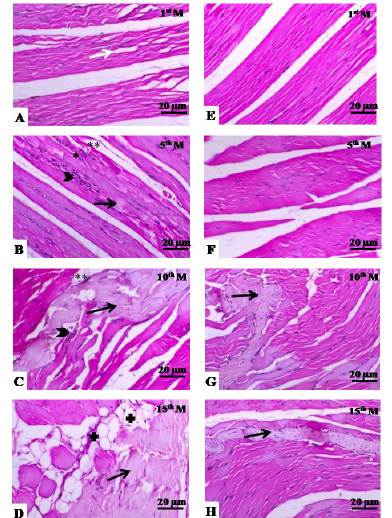
FIGURE 3 - Light photomicrographs of the rats gastrocnemius muscles stained with hematoxylin and eosin. (A- D) and (E- H): Rats that were taken a vehicle and quercetin, respectively. 1stM, 5thM, 10thM and 15thM include rats that had 1, 5, 10 and 15 month old, respectively. Note Focal myolysis (white arrow), cellular infiltration (arrowhead), Fragmentation (*), disruption (**), hyalinization (black arrow) of the muscle fibers and hyperplasia of adipocytes